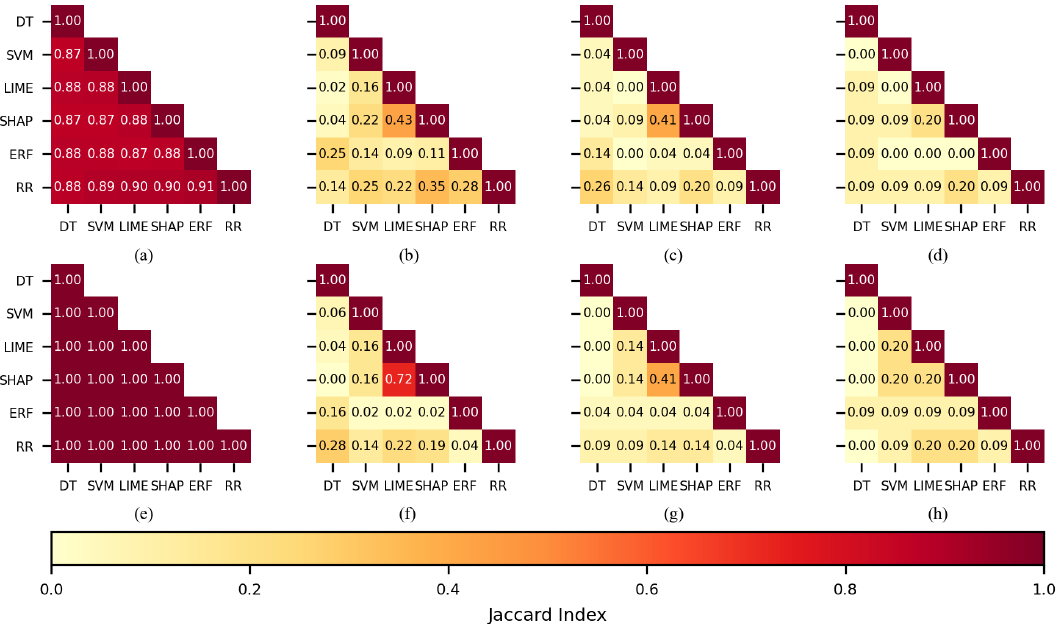
Figure 7. The similarity of the sets of features selected per each feature selection method when SVM was used as a classifier. CHB-MIT dataset: ( a ) best 450 features, ( b ) best 150, ( c ) best 100, and ( d ) best 50. Siena dataset: ( e ) best 450 features, ( f ) best 150, ( g ) best 100, and ( h ) best 50. The ANN classifier followed a similar pattern as SVM; SHAP-LIME obtained larger indices than most of the combinations, and these were 0.72 and 0.52 for 150 features, 0.71 and 0.50 for 100, and 1.0 and 0.33 for 50 (see Figure 8b–d,f–h), respectively. It should be noted that a Jaccard index of 1 means that both sets totally overlapped.